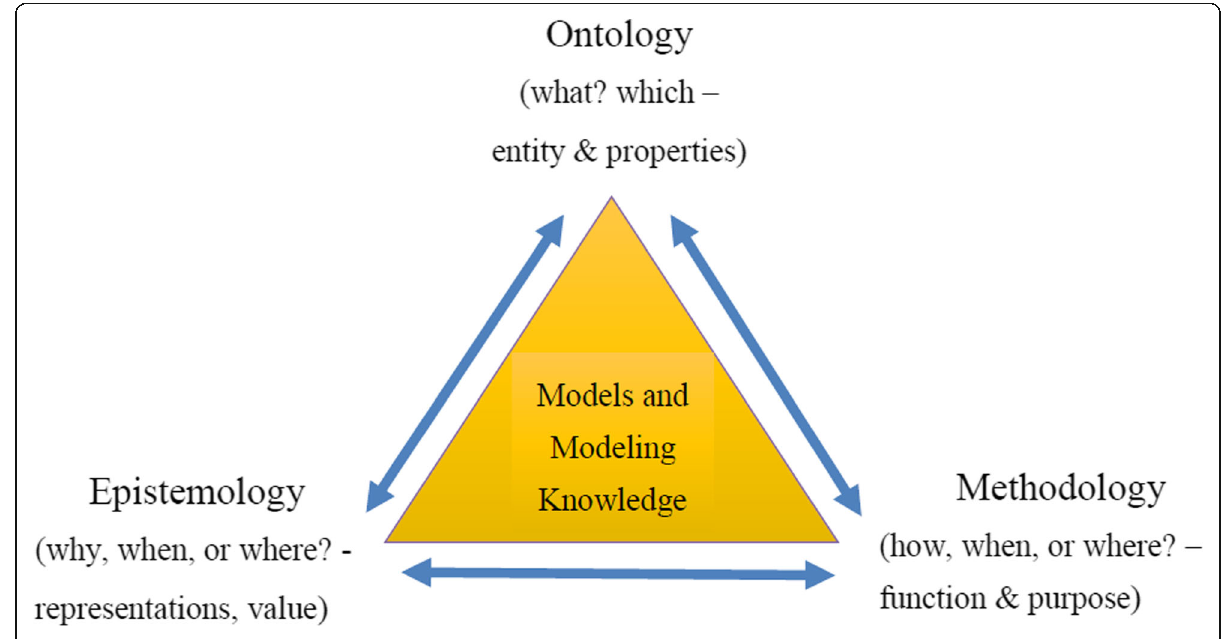
Fig. 2 The conceptual framework of models and modeling